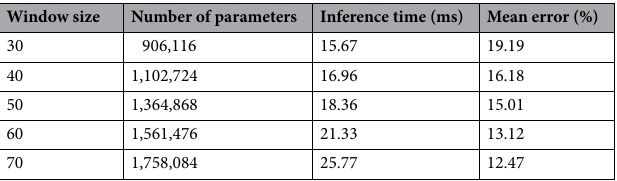
Table 2. Benchmarking results of DQN networks on the NCBI Virus Data Hub influenza dataset.